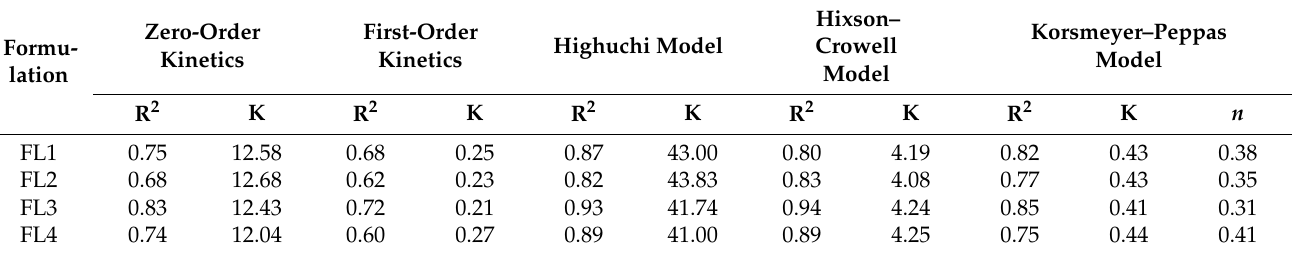
Table 3. Models of LUL release from ALG and ALG/GEL